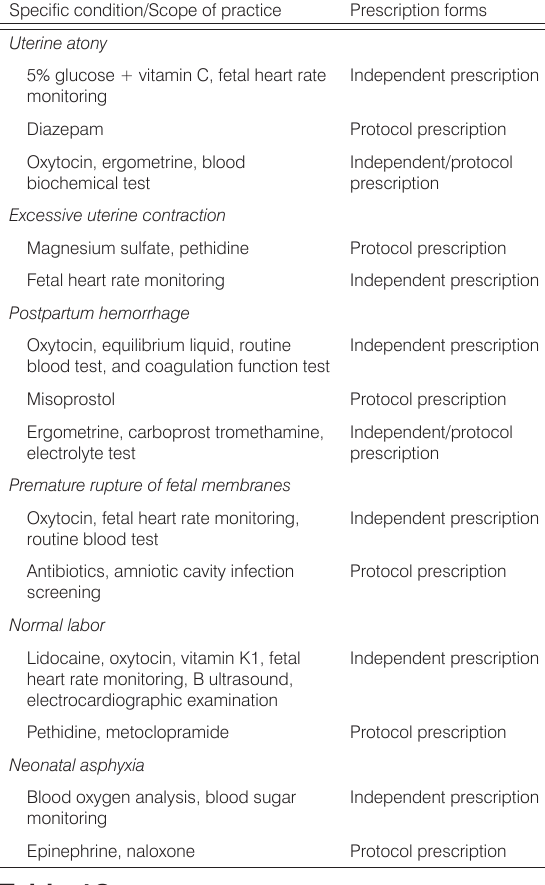
Table 12. Scope of practice of prescriptive authority for midwives in specific